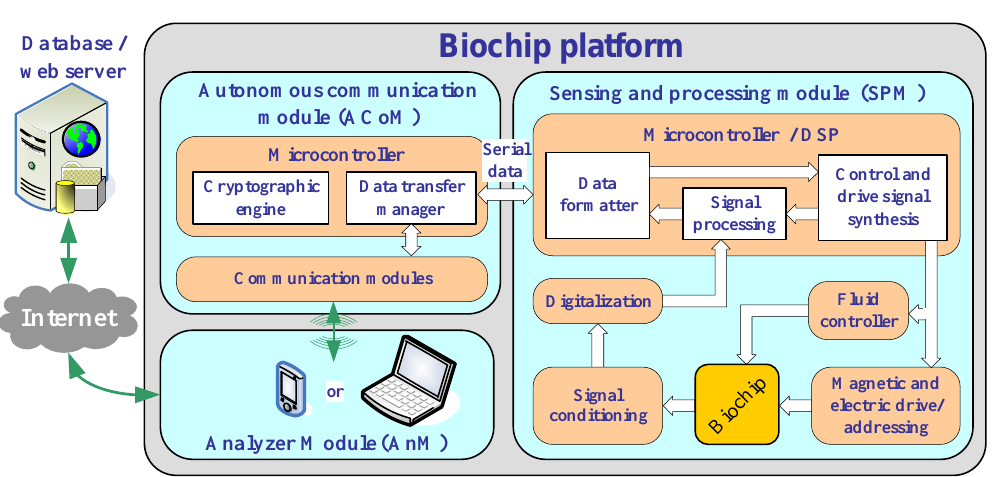
Figure 3. Architecture of the biochip